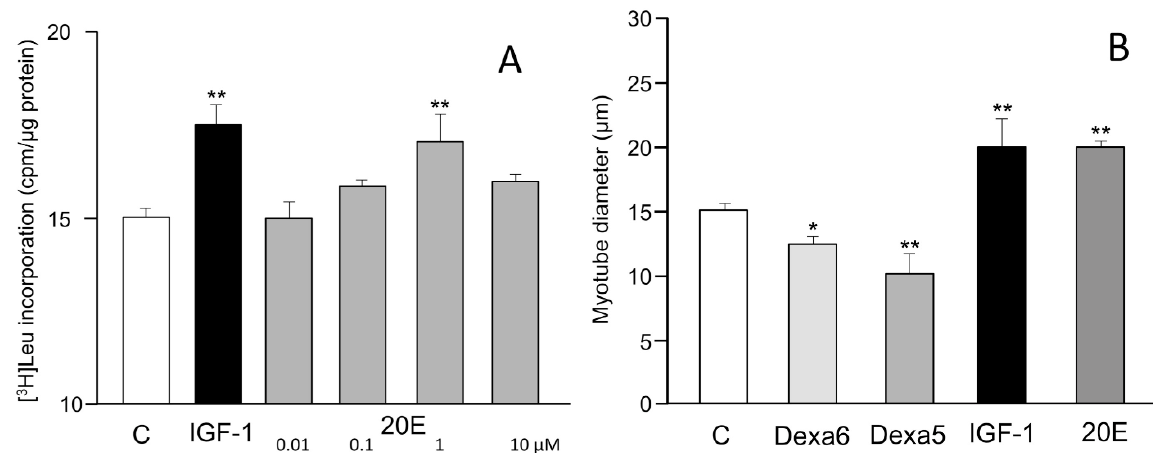
Figure 2. ( A ) The effects of 20E (0.01–10 µ M) on protein synthesis in C2C12 cells, showing the anabolic effect of 20E on optimal value for 1 µ M 20E. C2C12 cells were grown on 24-well plates at a density of 30,000 cells/well in 0.5 mL of growth medium (Dulbecco’s Modified Eagle Medium (DMEM) 4.5 g/L glucose supplemented with 10% fetal bovine serum). Twenty-four hours after plating, the differentiation induction into multinucleated myotubes was carried out, and after 5 days, cells were pre-incubated in Krebs medium 1 h at 37 ◦ C before being incubated in DMEM media without serum for 2.5 h in the presence of [ 3 H]-Leucine (5 µ Ci/mL) and DMSO (control condition) or IGF-1 (100 ng/mL) or 20E (0.01–0.1–1–10 µ M). At the end of incubation, supernatants were discarded and cells were lysed in 0.1 N NaOH for 30 min. The cell soluble fraction-associated radioactivity was then counted and protein was quantified using the Lowry method (after [103]). ( B ) Effects of dexamethasone (Dexa 6 = 10 − 6 M, Dexa 5 = 10 − 5 M), IGF-1 (10 ng/mL), and 20E (10 − 6 M) on the diameter of C2C12 myotubes. Four- to six-day-old myotubes were incubated for 48 h with test chemicals, and were fixed and photographed by glutaraldehyde-induced autofluorescence. *: p = < 0.05; **: p = 0.01. (redrawn and modified from [54]).